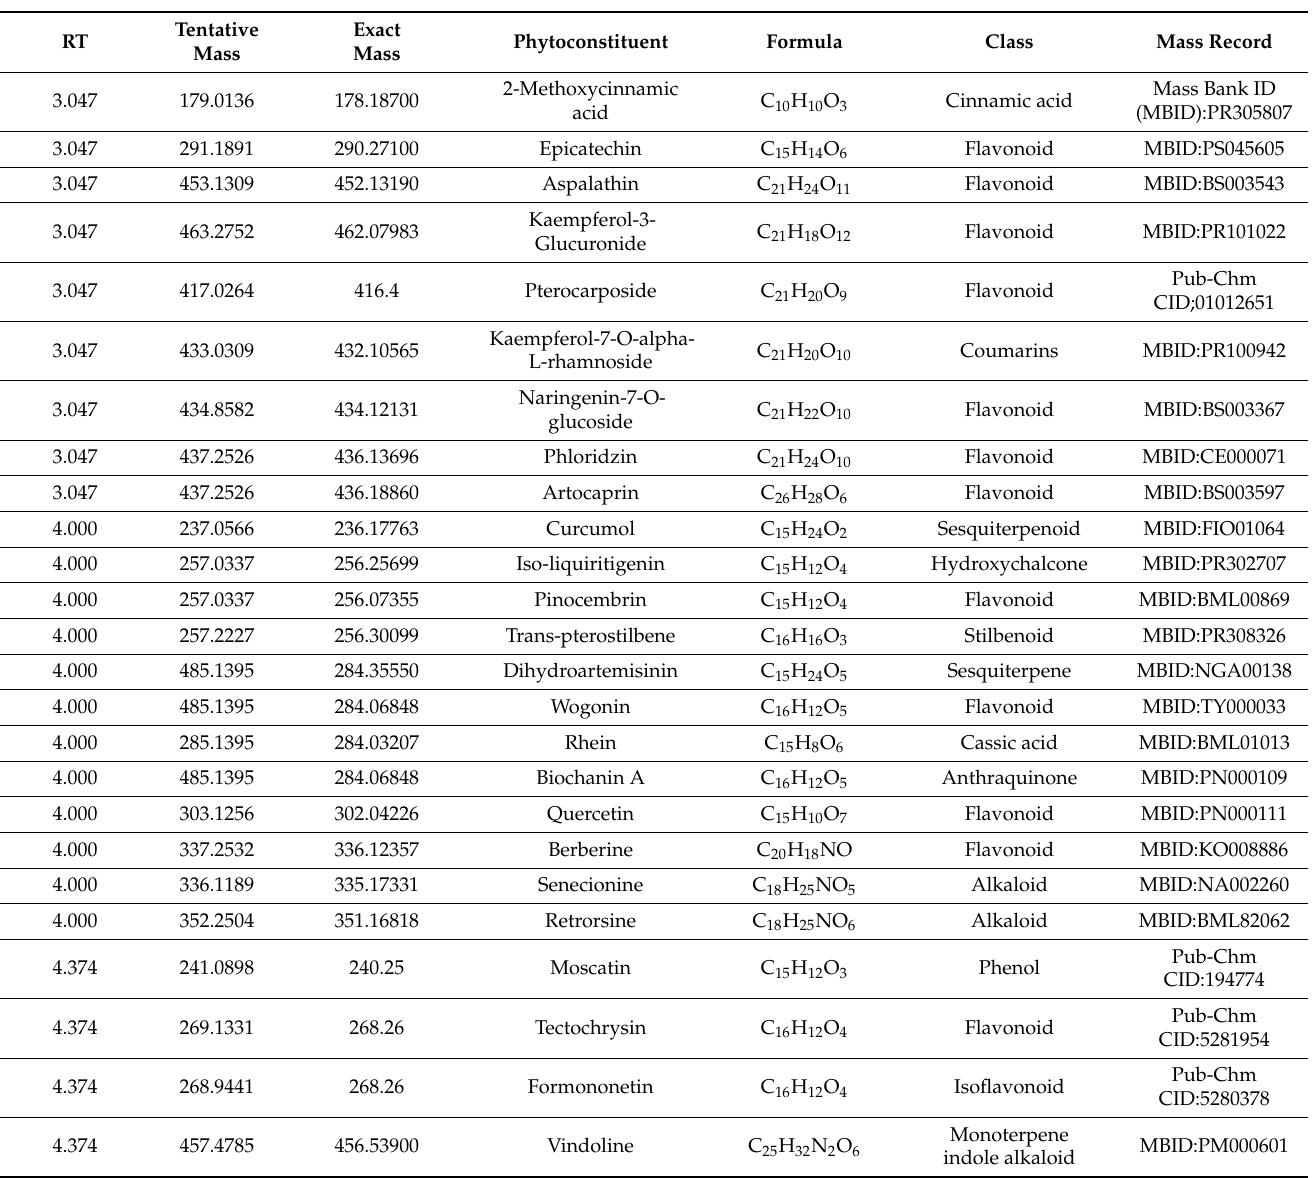
Table 2. List of Phytoconstituents identified by ultra-performance liquid chromatography-mass spectroscopy(UP-LCMS) in methanolic heartwood extract of Pterocarpus marsupium